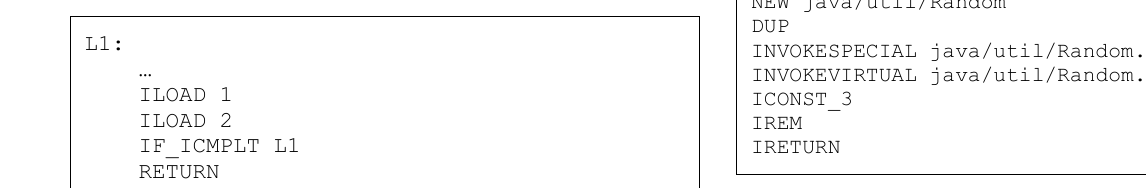
Fig. 9. Random number generation method.